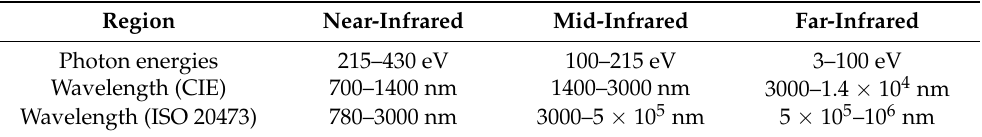
Table 1. Types of infrared light according to the International Commission on Illumination (CIE) and the International Organization for Standardization